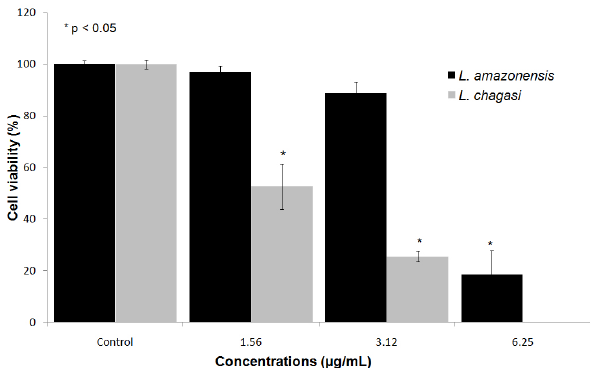
Figure 4. Leishmanicidal activity of different concentrations of BleuTV on promastigote forms of L. amazonensis and L. chagasi. The initial cell density was 1 x 10 6 cells/mL. The graph presents mean ± SEM (n = 3). BleuTV: whole venom of B. leucurus. *p < 0.05 compared to the corresponding control group.